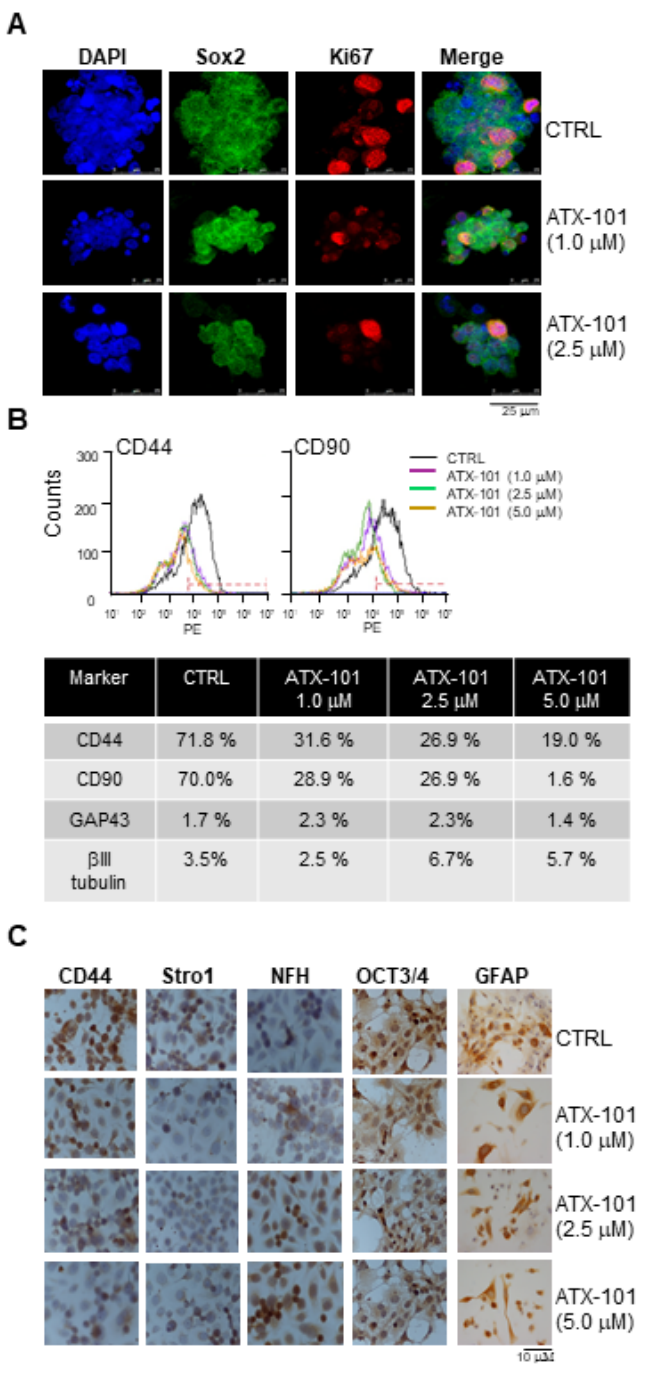
Figure 5. ATX-101 inhibits stemness phenotype and induces a reversion of Neural/proneural to mesenchymal phenotype. ( A ) Confocal analyses of Ki67- and Sox2-stained GSCs-5 cells treated with ATX-101 (1.0 and 2.5 µ M) for 48 h. Bar indicates 25 µ m. ( B ) FACS analyses for mesenchymal markers CD44 and CD90 in GSCs-5 cells after treatment with ATX-101 (1.0, 2.5, and 5 µ M) for 48 h. Percentages of cells positive for CD44, CD90, GAP43, and β III tubulin after treatment with ATX-101 are summarized in the table below the histograms. ( C ) ICC analyses performed on GSCs-5 cells for CD44, Stro1, NFH, OCT3/4, and GFAP after treatment with ATX-101 (1.0, 2.5, and 5 µ M) for 48 h. Bar indicates 10 µ